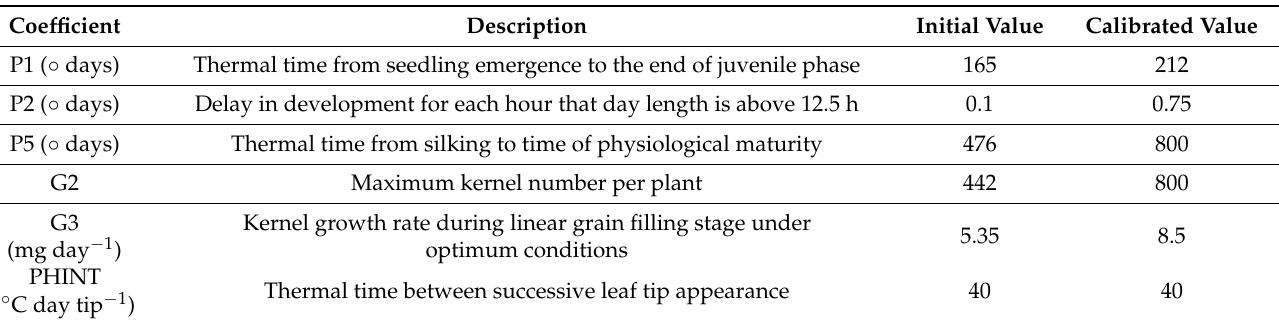
Table 6 . Genetic coefficients for the maize variety Ecavel.